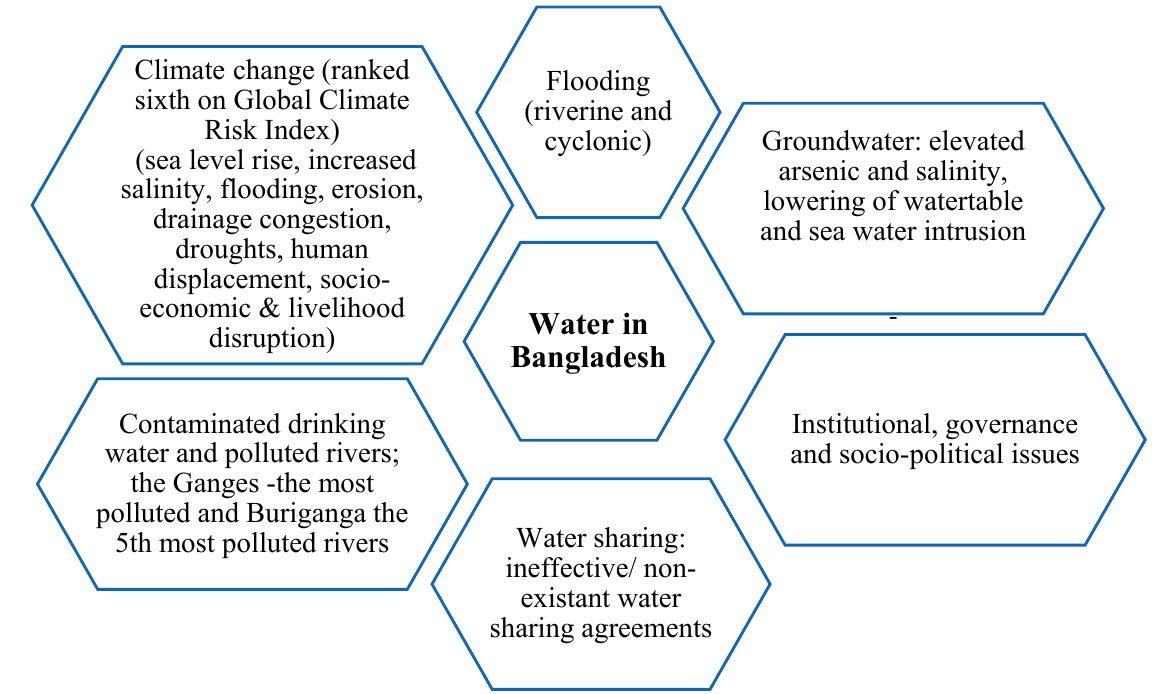
Figure 1. Illustration of major water issues in Bangladesh.